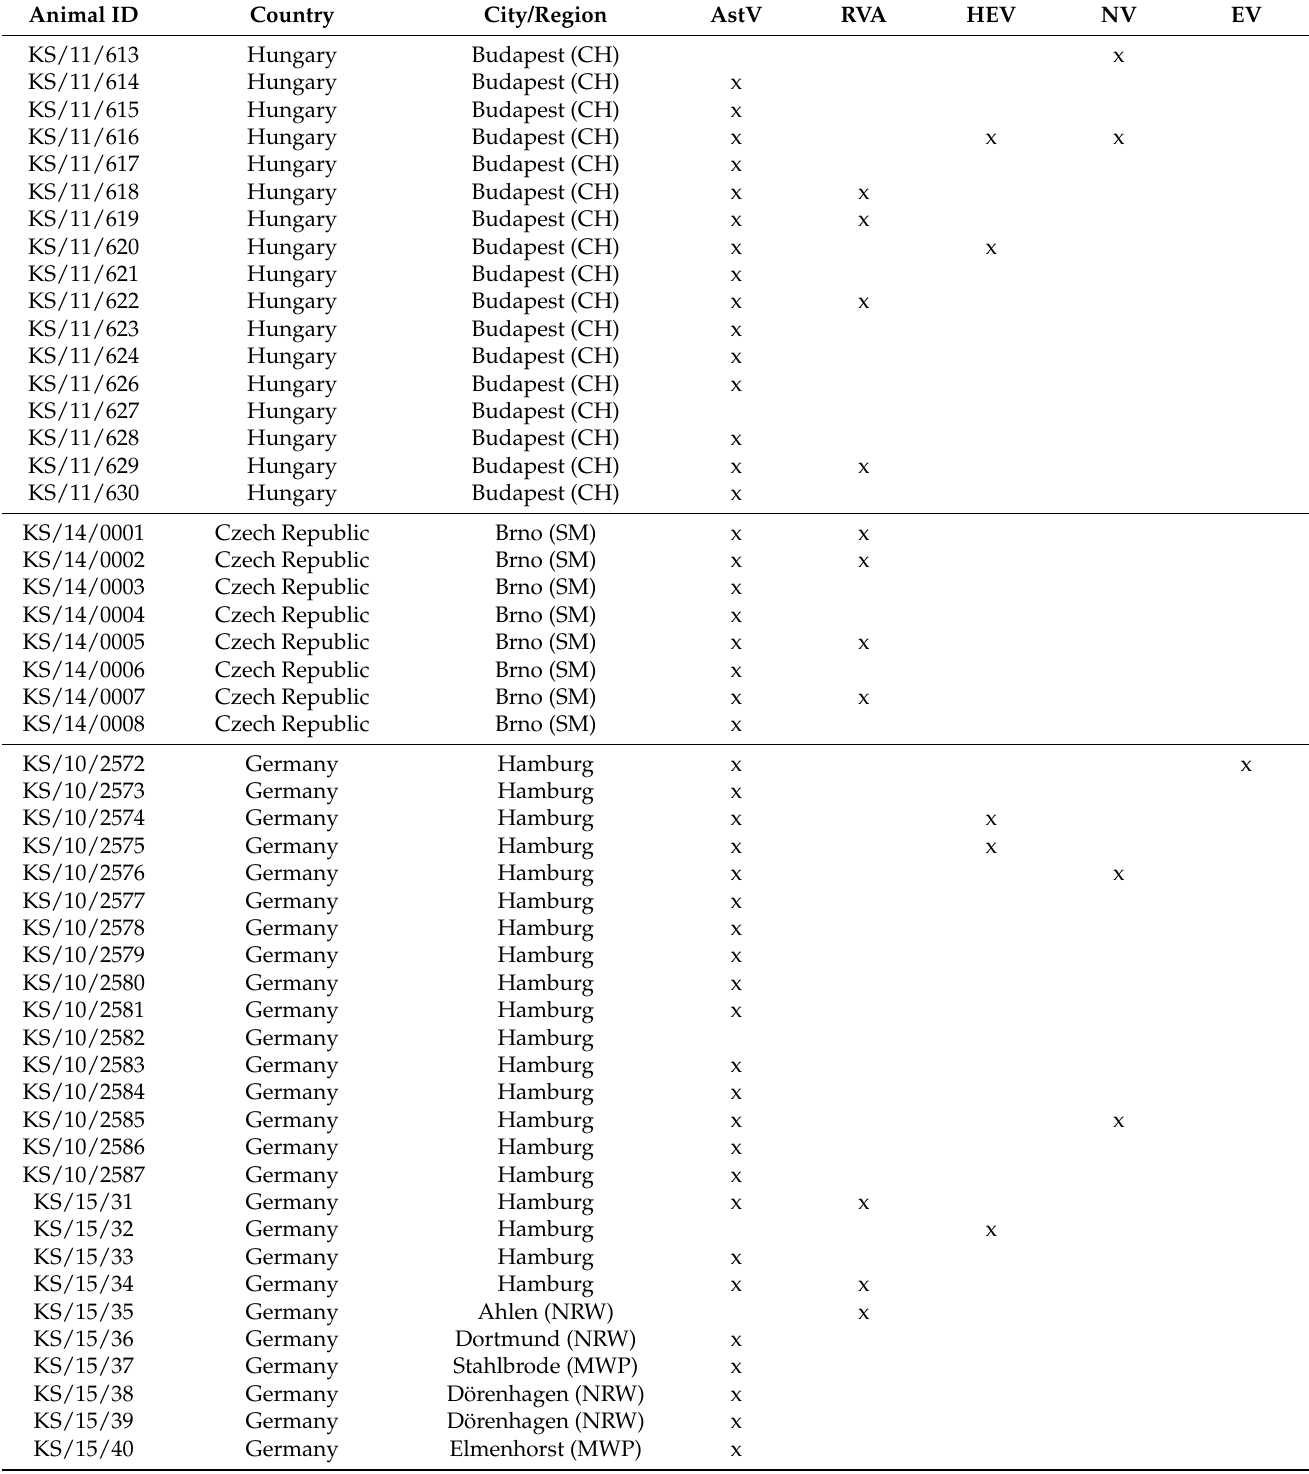
Table 1. Viral RNA detection in Norway rats of this